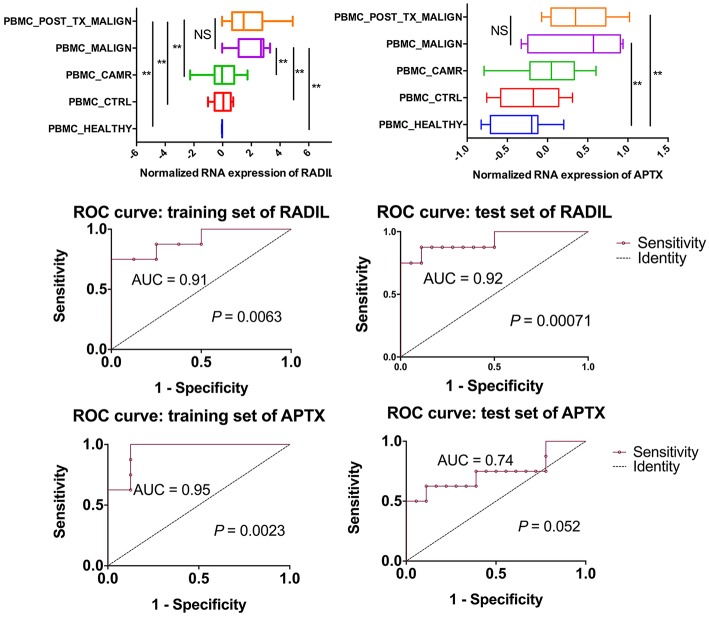
Further analysis on RADIL and APTX. The AUC of APTX was 0.93 in the training group and 0.75 in the test group, suggesting that APTX was not optimal. The AUCs of RADIL in both groups were more than 0.8.